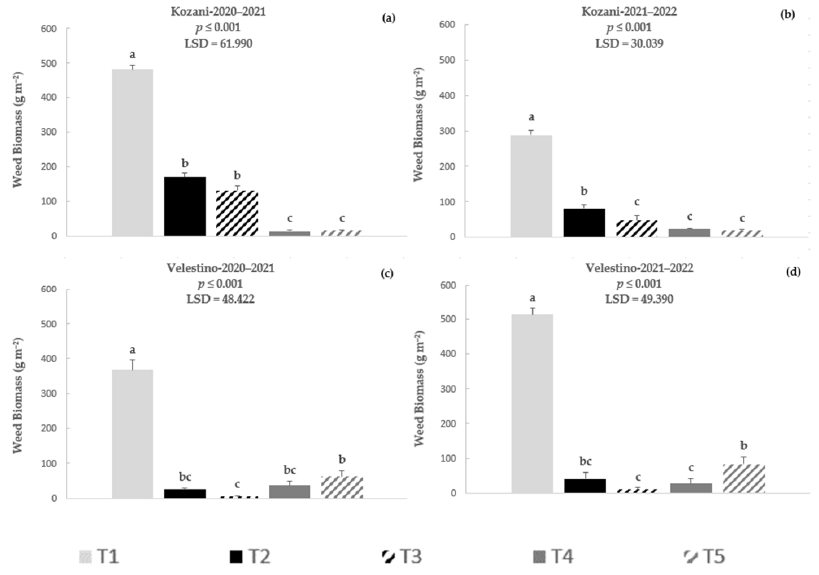
Figure 2. Weed biomass (g m − 2 ) in ( a ) Kozani-2020–2021, ( b ) Kozani-2021–2022, ( c ) Velestino-2020–2021, and ( d ) Velestino-2021–2022. Treatment DF: 4; Error DF: 15; Total DF: 19; DF: Degrees of Freedom. At each site-year, different lowercase letters indicate significant differences between treatment means according to Fisher’s LSD test ( a = 0.05). Vertical bars indicate standard errors.